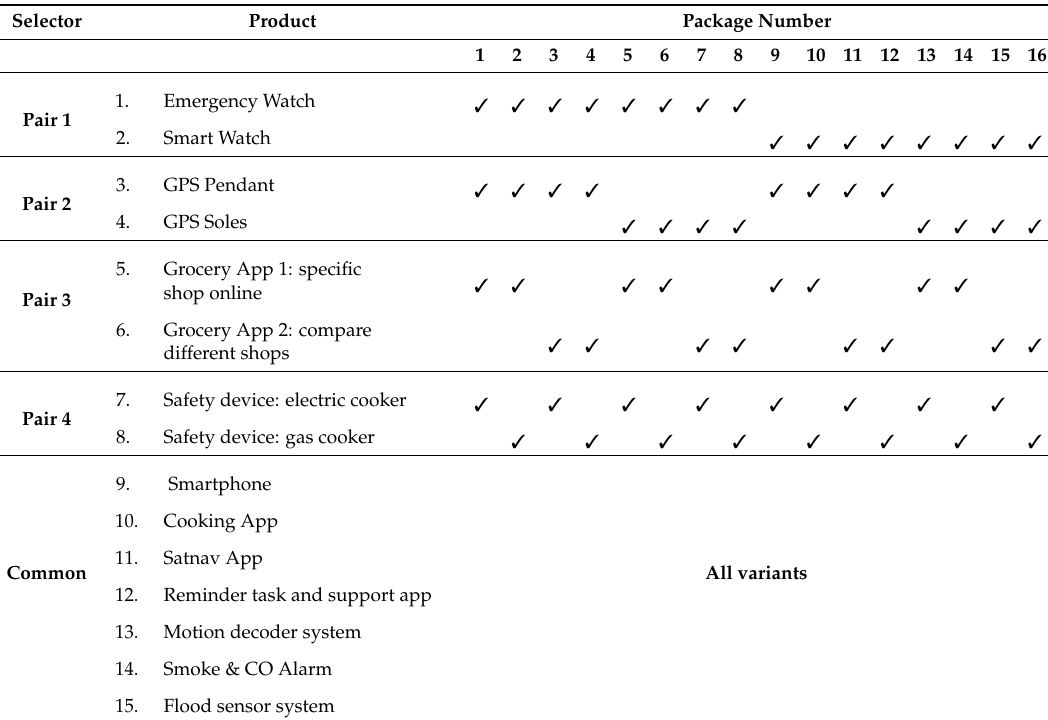
Table 1. Enabler package variants and their associated product mixes.